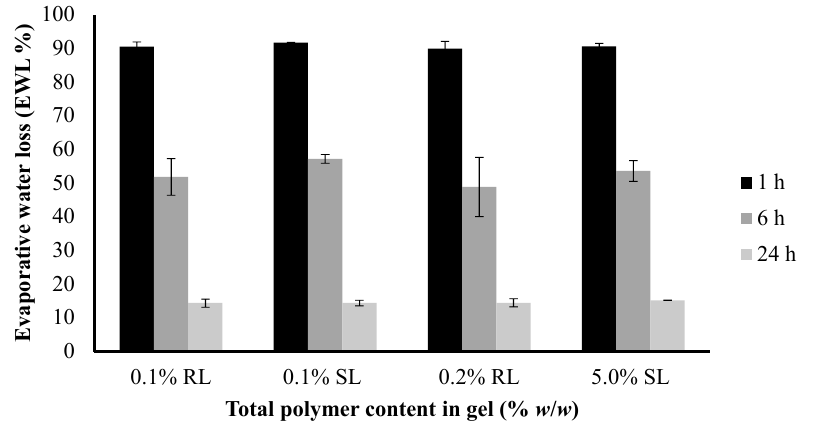
Figure 8. Comparison of the evaporative water loss (EWL) of optimized BLK and BSs loaded wafers.